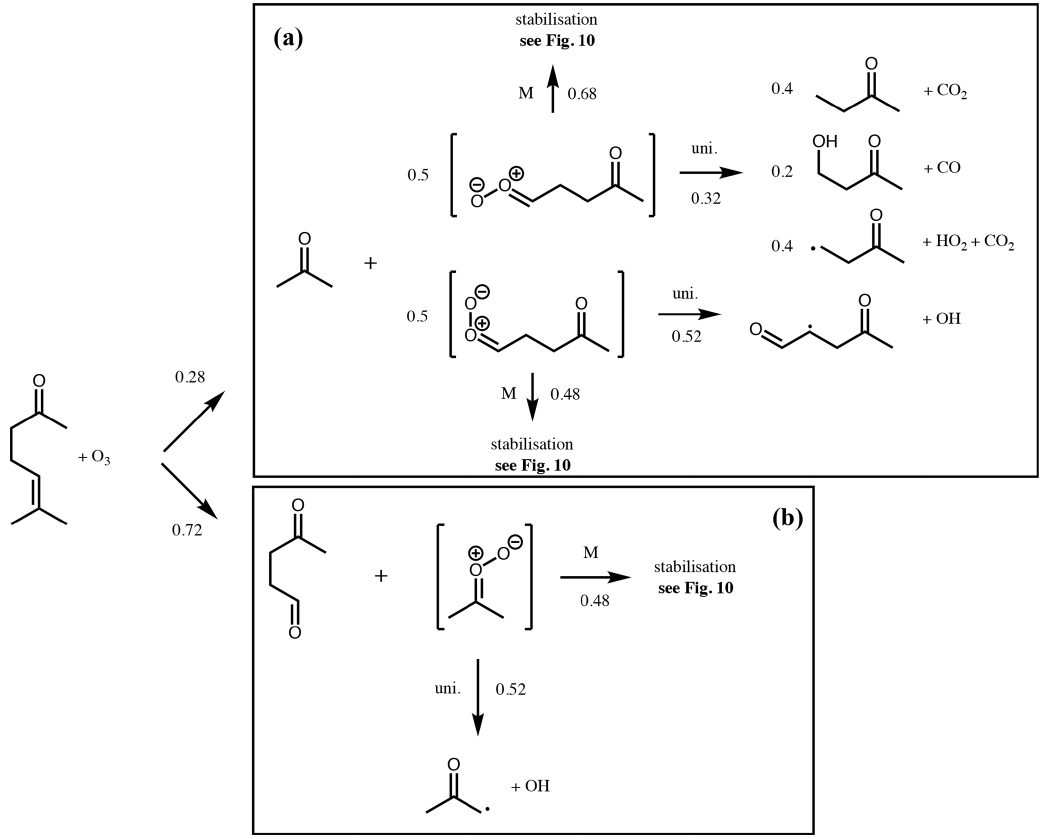
Figure 9. Branching ratios and products of the CI decomposition produced following ozonolysis of 6-methyl-5-hepten-2-one.